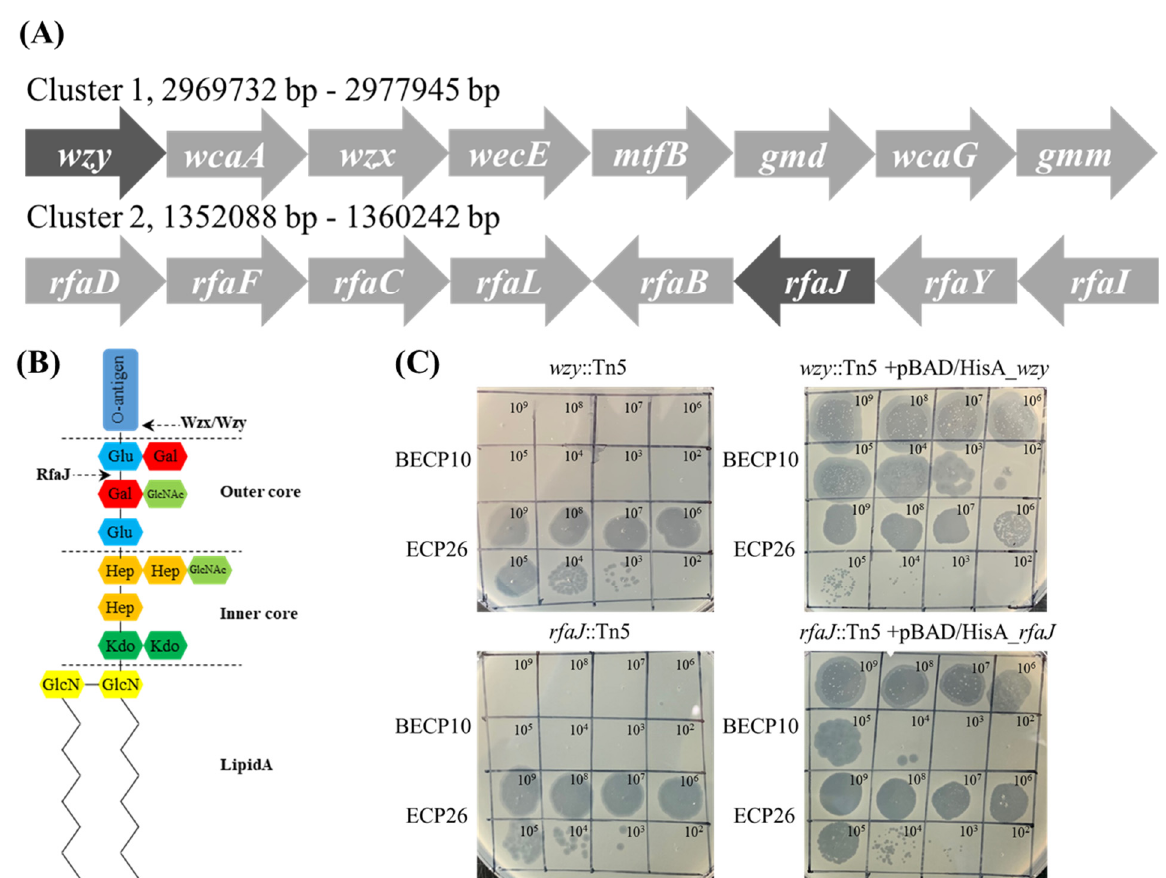
Figure 4. Identification of the BECP10 receptor using Tn5 random mutagenesis and complementation test. ( A ) Phages BECP10 and ECP26 were spotted on E. coli ATCC 43888 wzy ::Tn5 mutant, rfaJ ::Tn5 mutant, and their complementation strain (complemented by pBAD/HisA). ( B ) Composition of the O-antigen synthesis cluster (Cluster 1) and LPS core synthesis (Cluster 2). Dark shade means the Tn5 inserted gene. ( C ) Schematic of E. coli O157 LPS structure. RfaJ and Wzx/Wzy involved in outer core assembly and O-antigen synthesis, respectively.